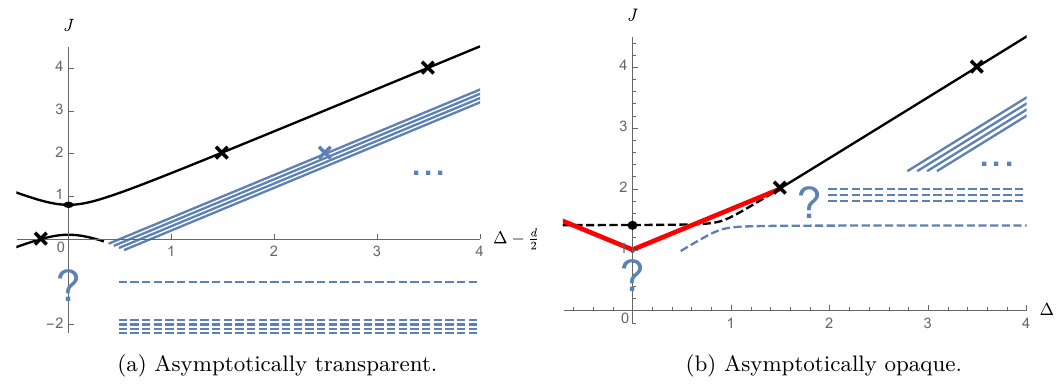
Figure 21 . Chew-Frautschi sketches for transparent and opaque theories. Solid lines indicate multi- twist trajectories, and dashed lines show possible BFKL-like horizontal trajectories. Complicated behavior could occur where accumulation points of trajectories intersect. (a) In scalar-like theories, most serious complications would seem restricted to J < 0 making analytic continuation to J = 0 plausible. (b) In nonabelian gauge theories, here at weak coupling, the perturbative leading trajectory has intercept j transient > 1 (solid disk). At higher orders in perturbation theory, near-horizontal ∗ composites with ever-increasing spin must exist. Singularities above the thick red lines must disappear nonperturbatively, by